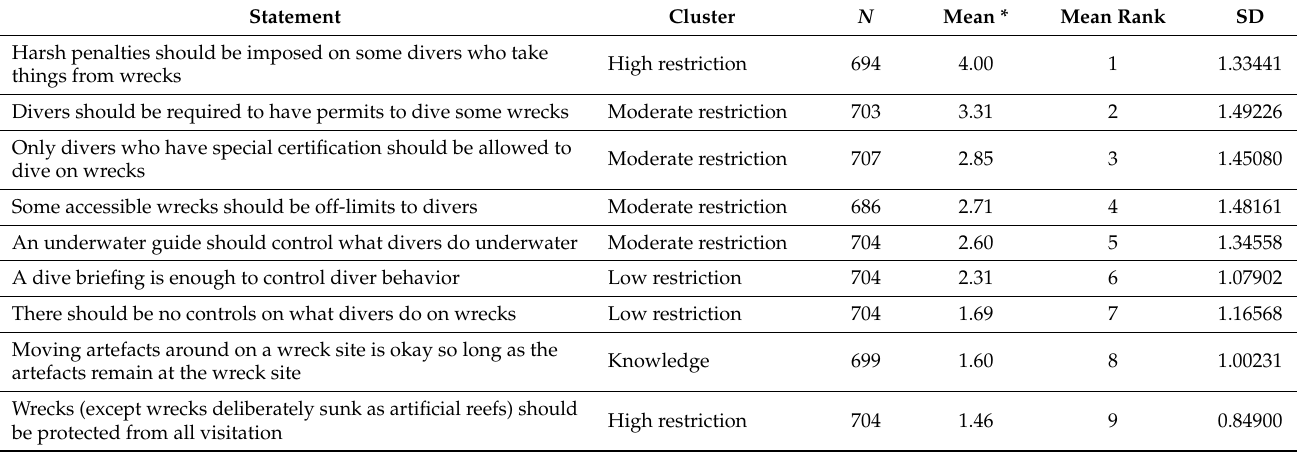
Table A5. Wreck diver attitudes to management controls (from